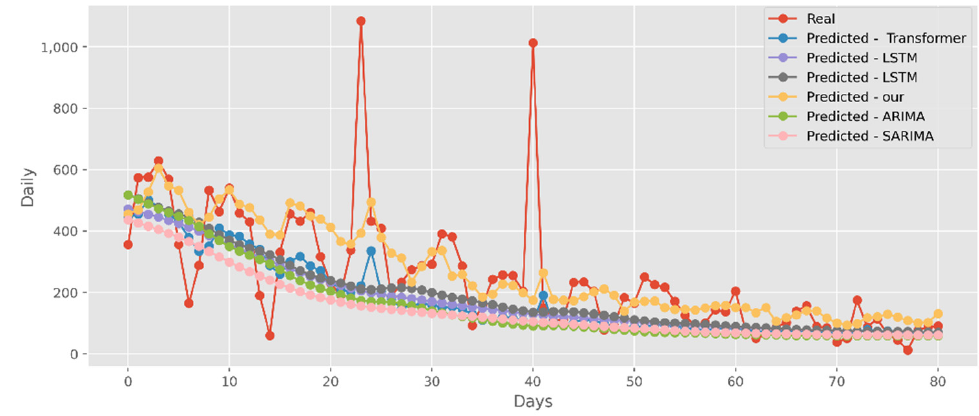
Figure 15. Comparison of COVID-19 prediction models of deaths in CA.